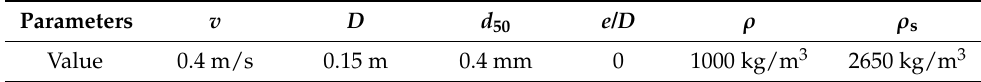
Table 2. Parameters of the model.